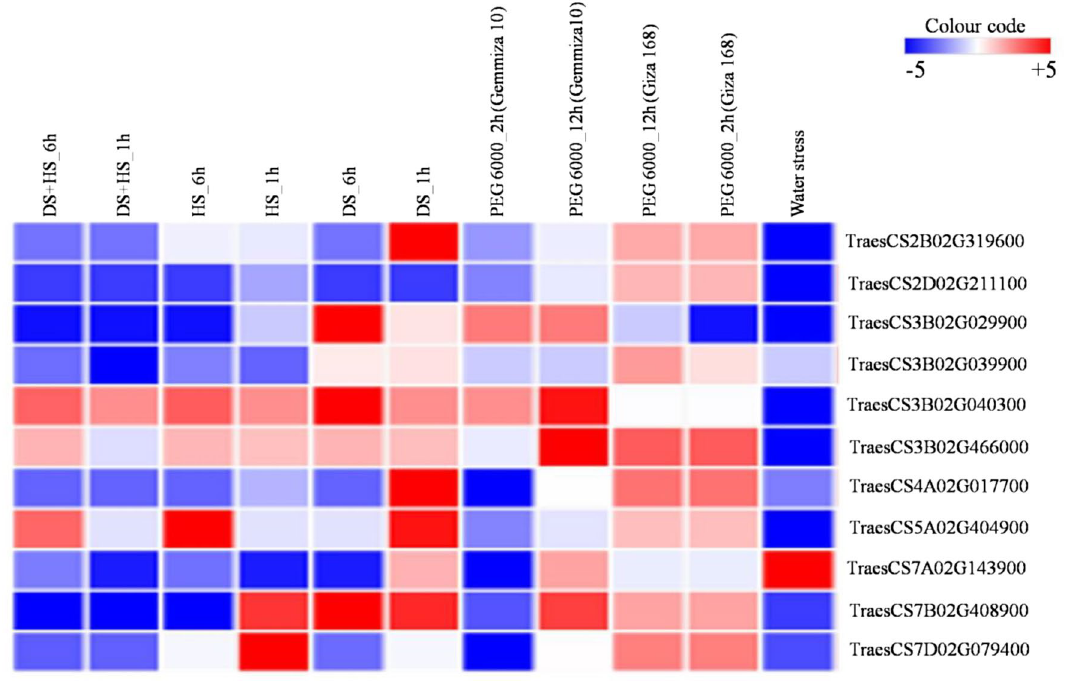
Figure 4. Expression patterns of 11 most promising candidate genes under different stress conditions. The scale shown on the right of heatmap represents the fold changes (ranging from − 5 to + 5) in expressions of candidate genes under different stresses.